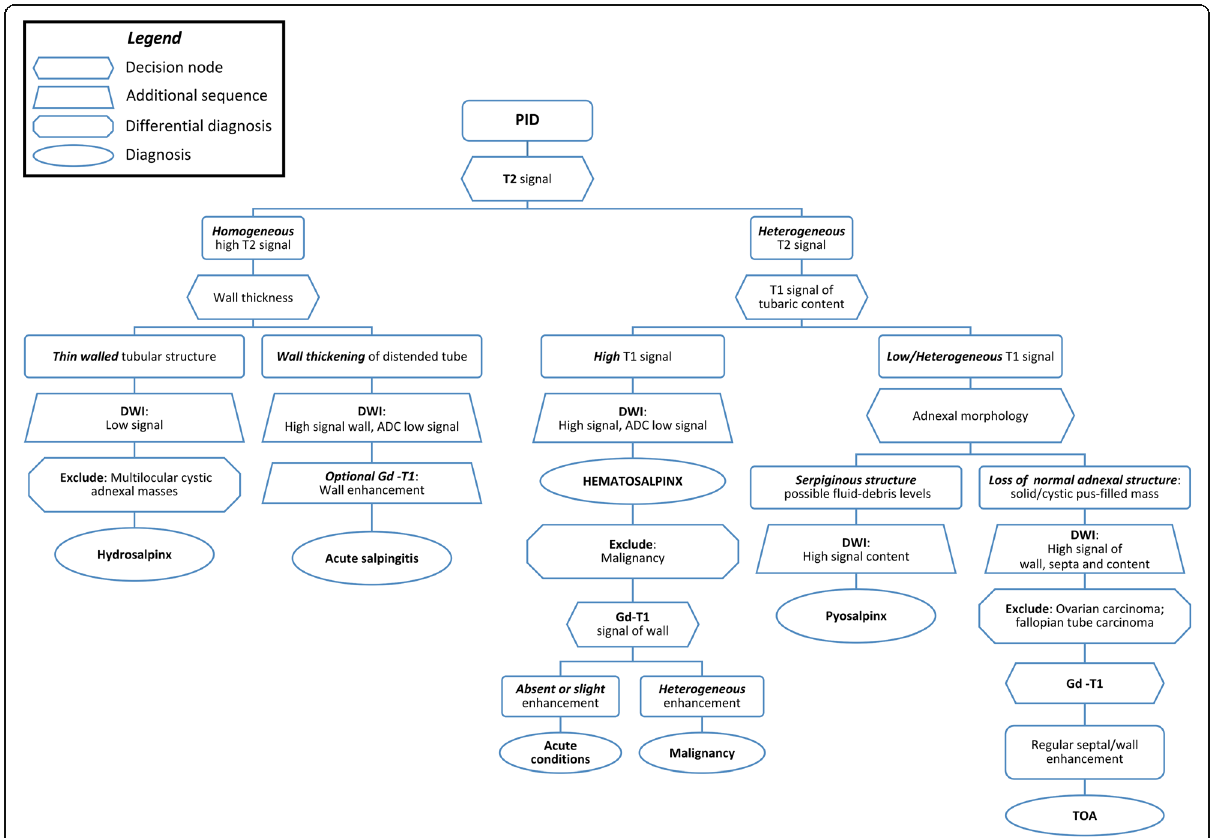
Fig. 8 Flow-chart showing the MRI algorithm that proposes diagnostic steps for characterisation and differential diagnosis of pelvic inflammatory disease (PID) forms, according to signal intensity features, diffusion restriction, mural thickness and contrast